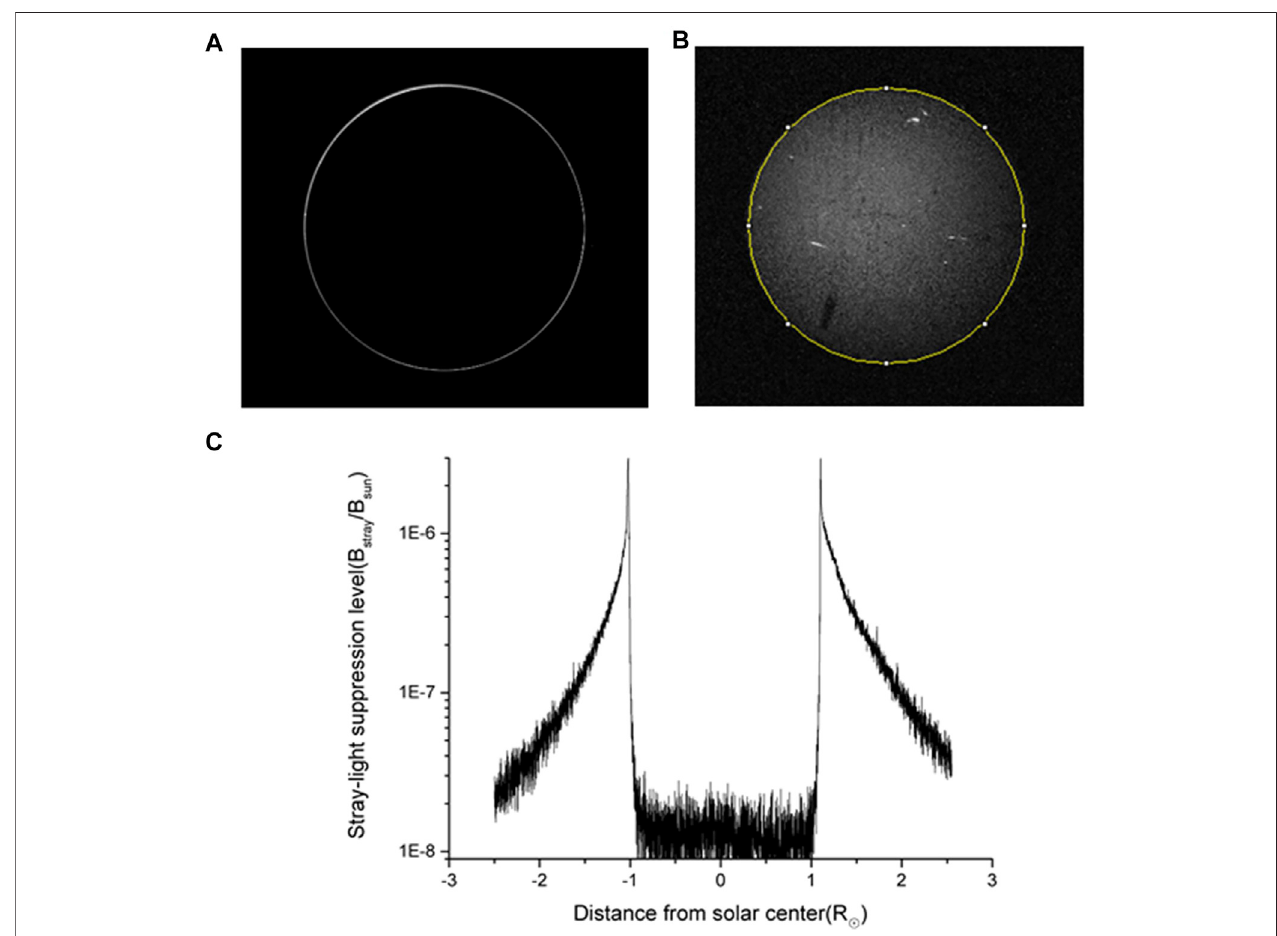
FIGURE 14 | (A) Stray-light image. (B) Solar disk image. (C) Stray-light suppression level as a function of the distance from the solar center.